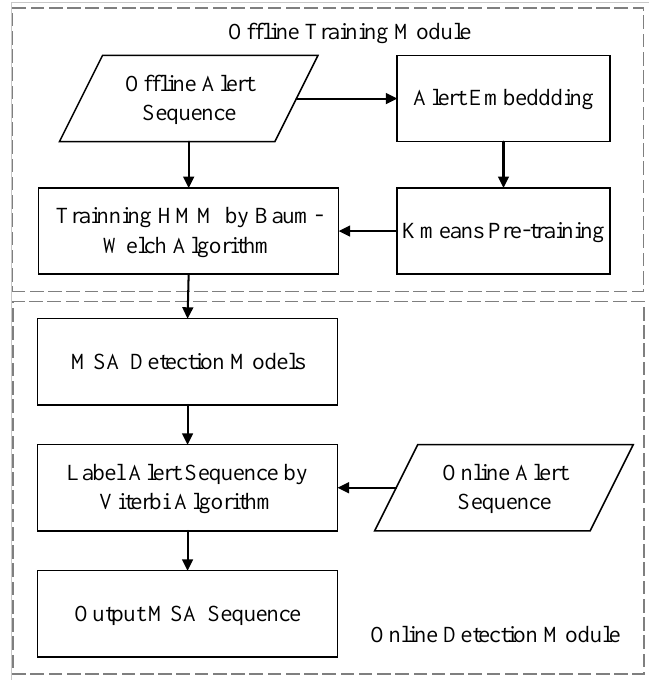
Figure 1. The proposed MSA-detection